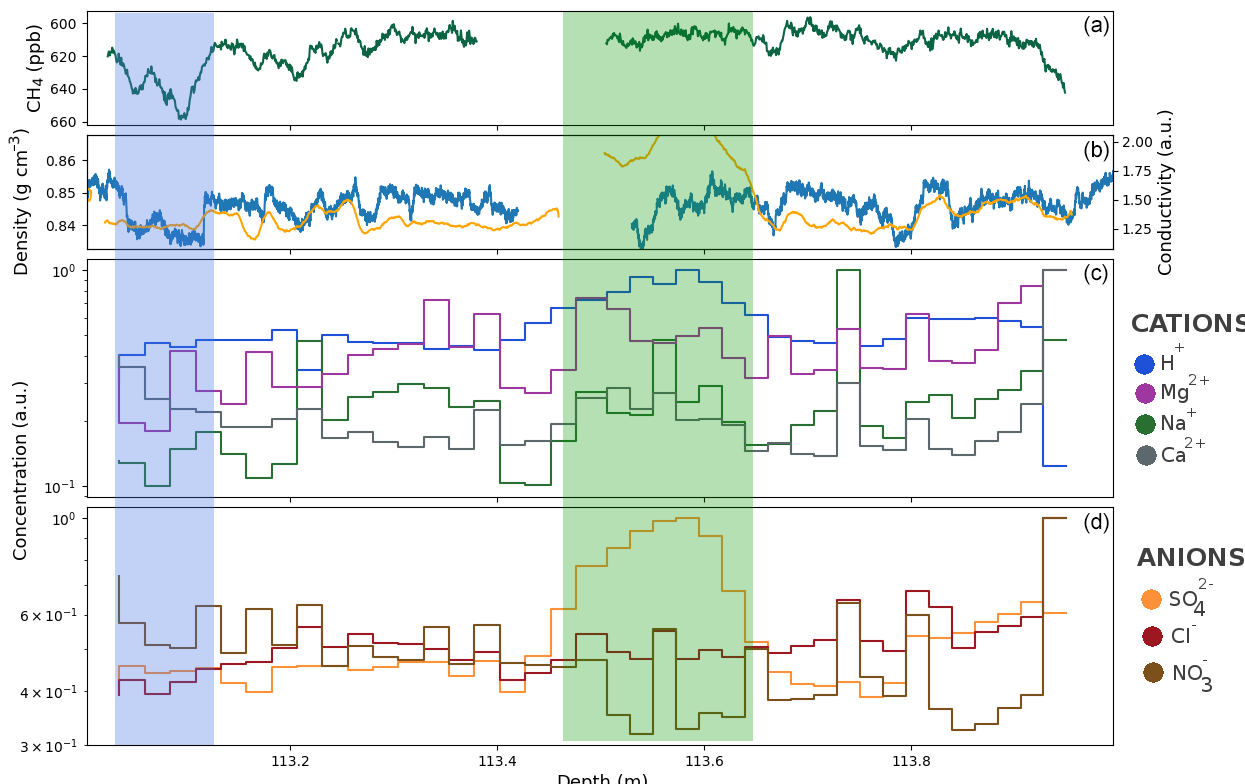
Figure 8. (a) Methane concentration measured by CFA between 113 and 114m depth, with a reversed axis. (b) Density (blue) and liq- uid conductivity (orange) variations. (c) Cation concentrations obtained with ion chromatography. (d) Anion concentrations obtained with ion chromatography. The ion concentrations are expressed in arbitrary units to highlight their variability. The green portion highlights the presence of a volcanic event. The blue portion highlights a partially open